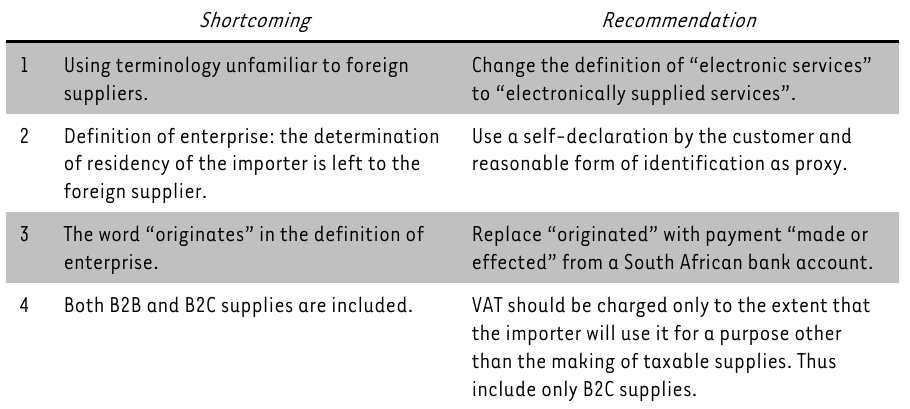
TABLE 2: Shortcomings and